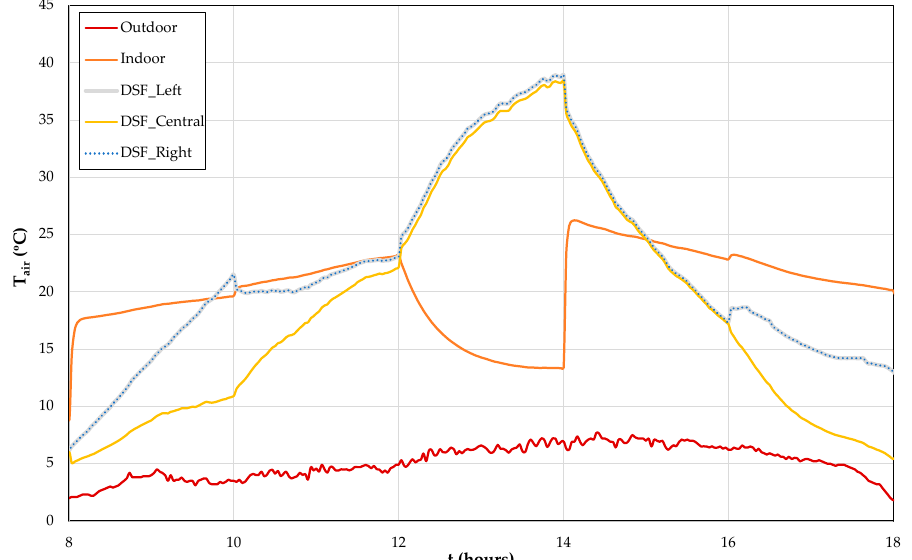
Figure 22. Evaluation of air temperature (T air ) of the outdoor environment, indoor virtual chamber and indoor left, central and right DSF system, when the airflow rate is variable and the number of DSFs to operate is variable, for the Case J.